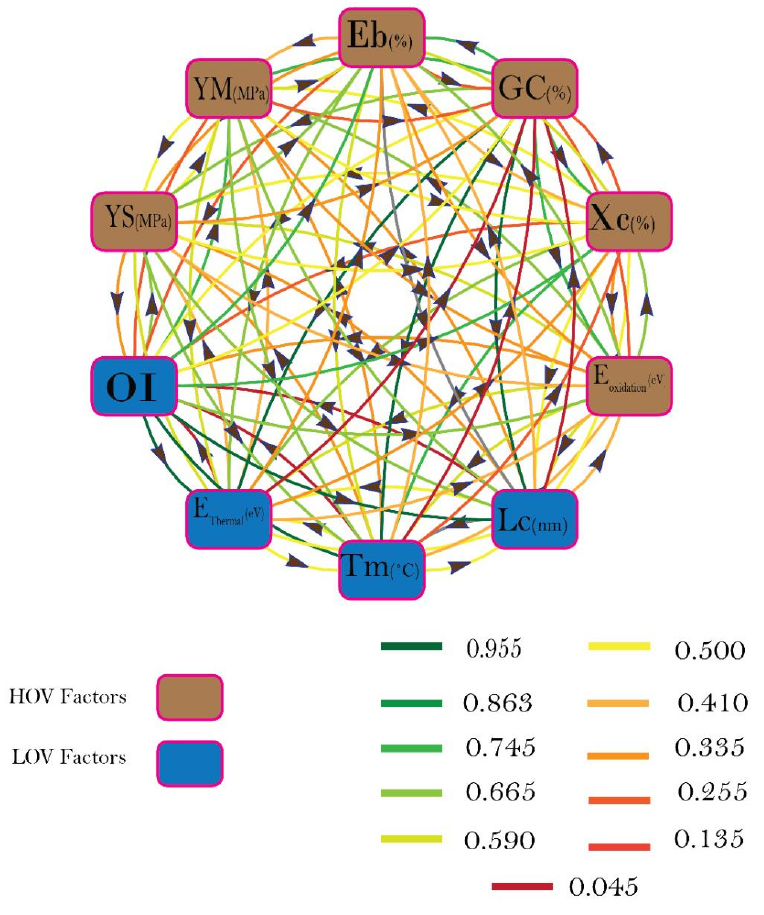
Figure 4. Self-descriptive material selection graph for this study with mentioned HOV and LOV factor and weight–age of relative importance’s among each factor. Table 2 indicates quantitative values of structural attributes, i.e., OI, GC, Xc, and T m , and performance attributes, i.e., E thermal , E oxidation , E b , Lc, YS, and YM), these are normalized while using their importance as HOV and LOV